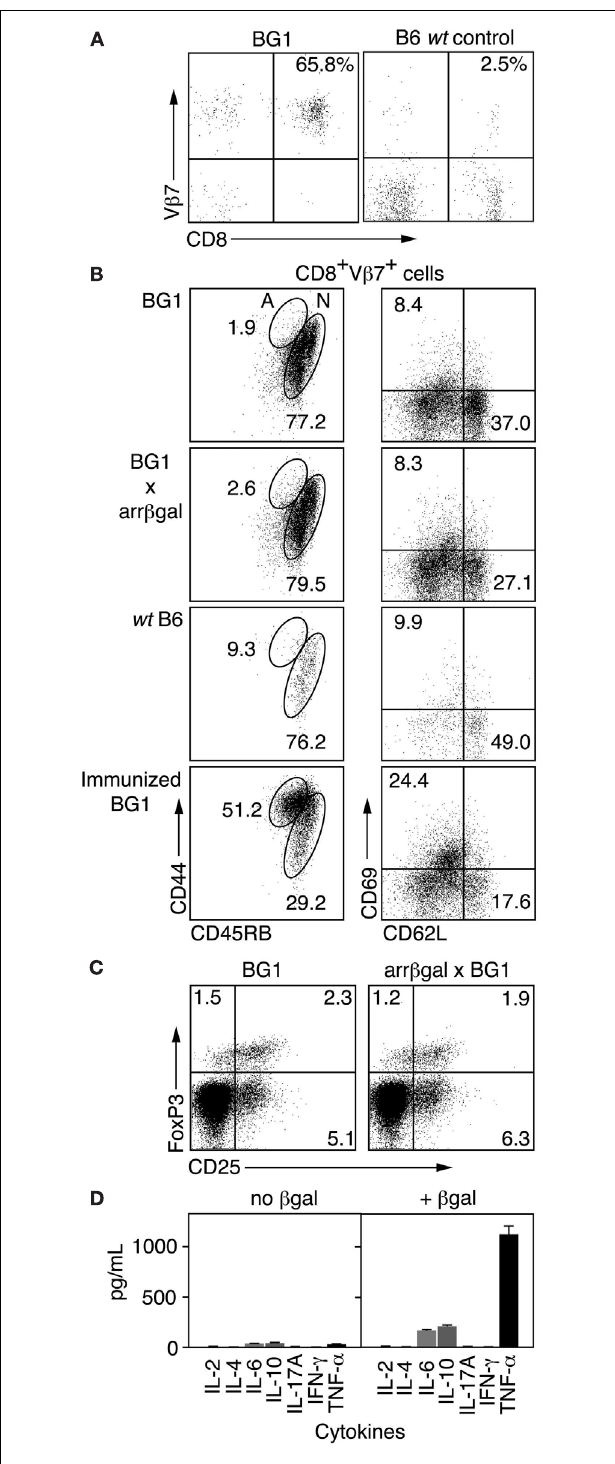
FIGURE 1 |Analysis of β gal-specific BG1TCRTg mice. (A) FACS analysis of CD3 + splenocytes for CD8 and the clonotypicTCR β chain for the BG1Tg mice. (B) FACS analysis for cell surface molecules associated with Ag recognition. Lymphocytes were gated on CD8 + V β 7 + and then analyzed for the indicated surface molecules.The percentage of cells having a naïve (N)